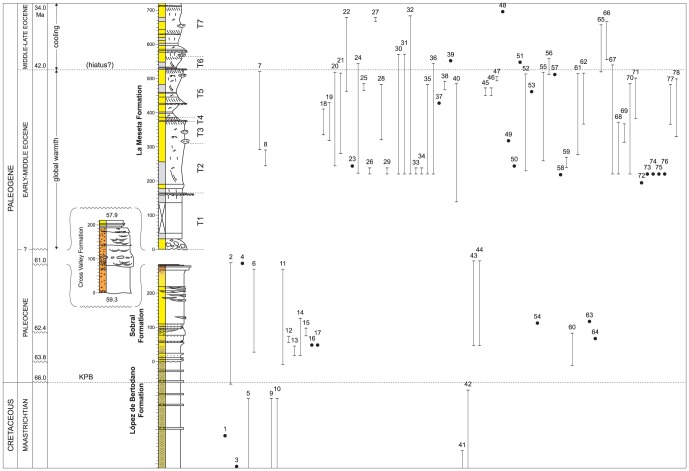
The stratigraphical radiation of the Neogastropoda in Antarctica.Solid lines and dots depict actual fossil occurrences and ranges of 80 neogastropod species. Full details as to how the occurrences and ranges were established within the stratigraphic framework are contained within the text and S2 Appendix. Klb 9 represents the topmost Maastrichtian stratigraphic unit of the LBF, KPB =  Cretaceous/Paleogene boundary, and (10) is Kplb 10, the recovery interval and topmost informal stratigraphic unit of the LBF. T1–7 =  Telms 1–7 of the LMF; ages (in Ma) are approximate and taken from Montes et al. [117] for the SF, CVF and topmost LMF. Further details on the age of the La Meseta Formation are given in S1 Appendix. Gastropods arranged in taxonomic order according to Bouchet & Rocroi [118]. 1.Heteroterma sp. 2; 2. Heteroterma sp.; 3. Antarctissitys austrodema; 4. Pyropsis sp.; 5. Taioma charcotiana; 6. Taioma sobrali; 7. Taioma bicarinata; 8. Taioma? antarctocarinata; 9. “Cassidaria” mirabilis; 10. Neogastropod, n. gen. B; 11. Austrosphaera bulloides; 12. n. gen. woolfei; 13. “Colus” delrioae; 14. Probuccinum? palaiocostatum; 15. cf. Germonea n. sp.; 16.?Pseudotylostoma pyrinota; 17. n. gen.? polaris; 18. “Penion” n. sp. A; 19. “Penion” n. sp. B; 20. Penion australocapax; 21. Prosipho stilwelli; 22. Prosipho lawsi; 23. Prosipho delli; 24. Prosipho polaris; 25. Prosipho antarctocosta; 26. Prosipho n. sp. 1; 27. Prosipho lamesetaensis; 28. Pareuthria hookeri; 29. Pareuthria n. sp. 1; 30. Chlanidota antarctica; 31. Chlanidota tuberosa; 32. Chlanidota antarctohimaleos; 33. Chlanidota?antarctohimaleos; 34. Chlanidota n. sp. 1; 35. Austroficopsis seymourensis; 36. Austroficopsis wimani; 37. Austroficopsis australis; 38. Austroficopsis austrinus; 39. Austroficopsis meridionalis; 40. n. gen. verrucosa; 41. Neogastropod, n. gen. A; 42. Cryptorhytis philippiana; 43. Microfulgur binodosa; 44. Paleopsephaea? nodoprosta; 45. Fusinus? doylei; 46. Microfulgur byrdi; 47. Fusinus? eonodatus; 48. Fusinus? suraknisos; 49. Fusinus? graciloaustralis; 50. Trophon radwini; 51. Eupleura suroabdita; 52. Turbinellidae indet.; 53. Fulgurofusus brecheri; 54. Miomelon? sp.; 55. Adelomelon fordycei; 56.?Adelomelon suropsilos; 57. Odontocymbiola amundseni; 58. Miomelon antarctica; 59. Tractolira n. sp.; 60. Volutomitra? antarctmella; 61. Volutomitra? cernohorskyi; 62. Volutomitra? iredalei; 63. Marshallaria? sp.; 64.?Cosmasyrinx (Tholitoma) antarctigera; 65. Zemacies finlayi; 66. Aforia canalomos; 67. Marshallaria? oliveroi; 68. Austrotoma n. sp.; 69. Austrotoma? ventricosa; 70. Austrosullivania lata; 71. Austrosullivania striata; 72. Gemmula askinae; 73. Spirotropis? n. sp.; 74. Typhlomangelia? n. sp.; 75. Agladrillia? n. sp.; 76. Makiyamaia? n. sp.; 77.? Splendrillia antarctoliqua; 78.? Cochlespira brychiosinus; 79. Pristimercia australis; 80. Coptostomella? notopolaris. Species 1–10 unassigned to superfamily; 11–49, Buccinoidea; 50–62, Muricoidea; 63–78, Conoidea; 79–80, Cancellarioidea.